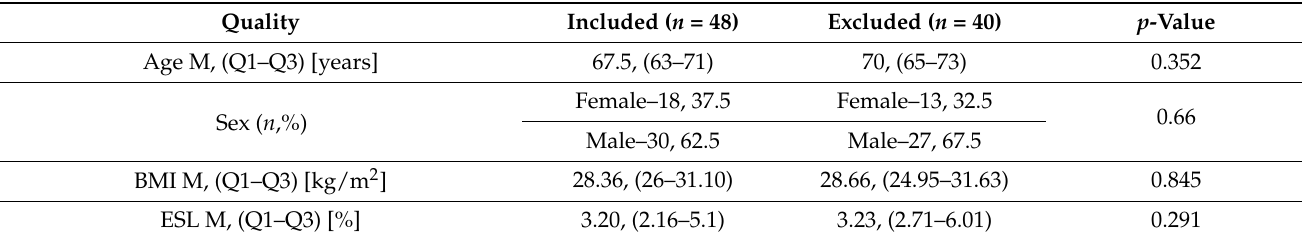
Table 3. Baseline characteristics and operation-related data of all patients initially enrolled into the study ( n = 88). Quality Included ( n = 48) Excluded ( n = 40) p -Value Age M, (Q1–Q3)